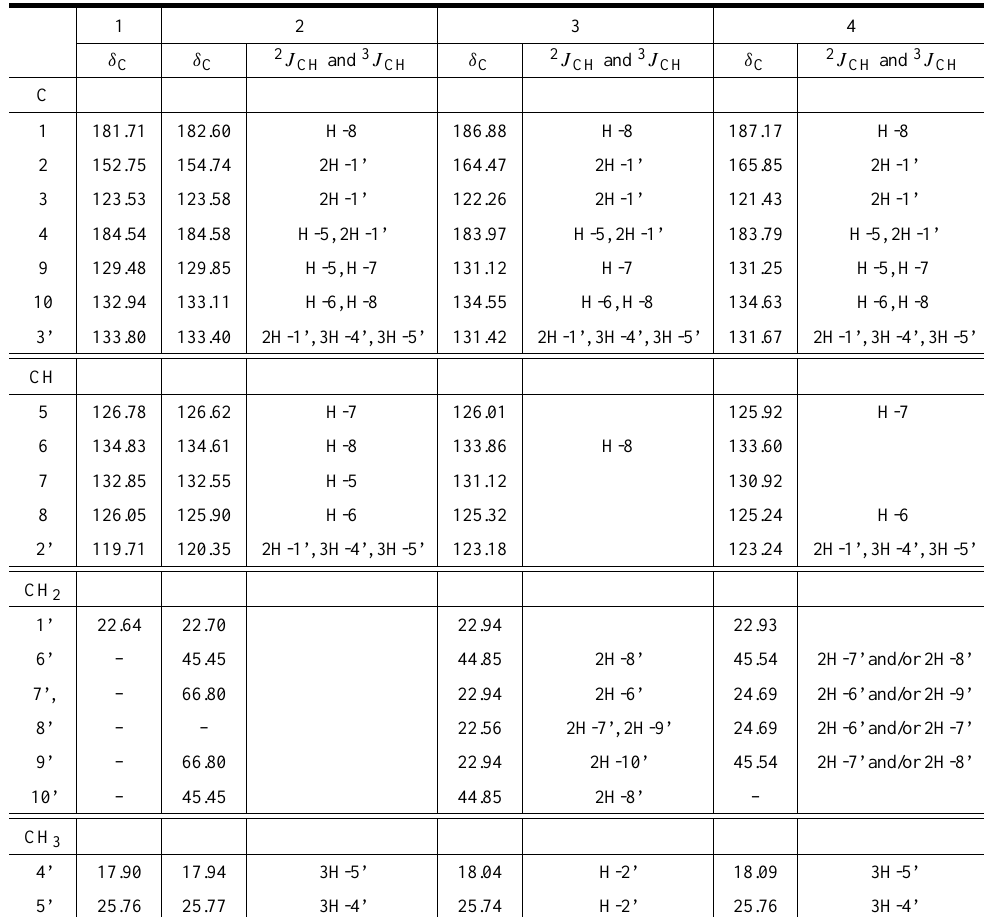
13 C NMR and heteronuclerar long-range couplings ( 2 J (1) and the enamine derivatives 2-4. Chemical shifts in δ C (ppm), in CDCl 3 and TMS as internal